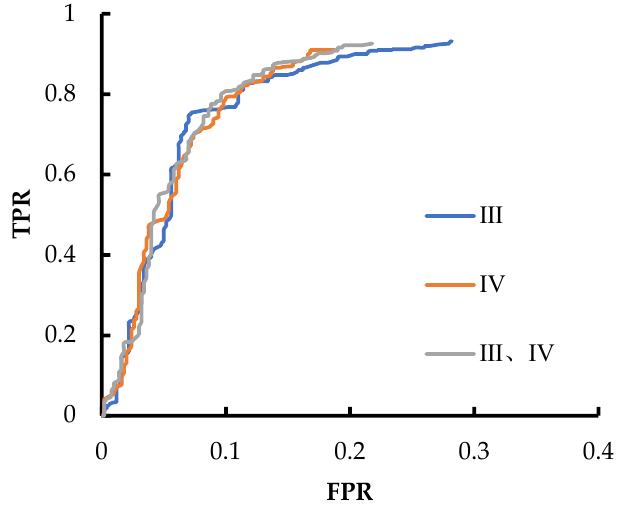
Figure 10. Extraction results of three combinations of phenological periods. Table 5. DTW threshold and winter wheat extraction results of the combined time series of optimal phenological period combinations in the overall quadrat.